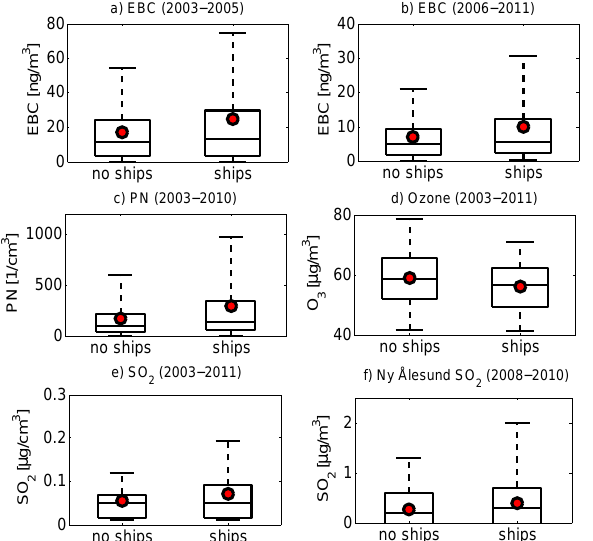
Fig. 4. Box and whisker plots of EBC (a, b) , particle number con- centration for particles in the 60nm size bin (c) , ozone (d) , SO 2 at Zeppelin (e) , and SO 2 at Ny Ålesund (f) , for the two periods when ships are present in the harbor, or not. In the title of each panel the years used for the analysis are reported. The boxes extend from the 25th to the 75th percentile, the whiskers show the 5th and 95th per- centile, and the thick red dots are the mean values. Data shown are for summer (June, July, August) daytime (06:00–18:00UTC).